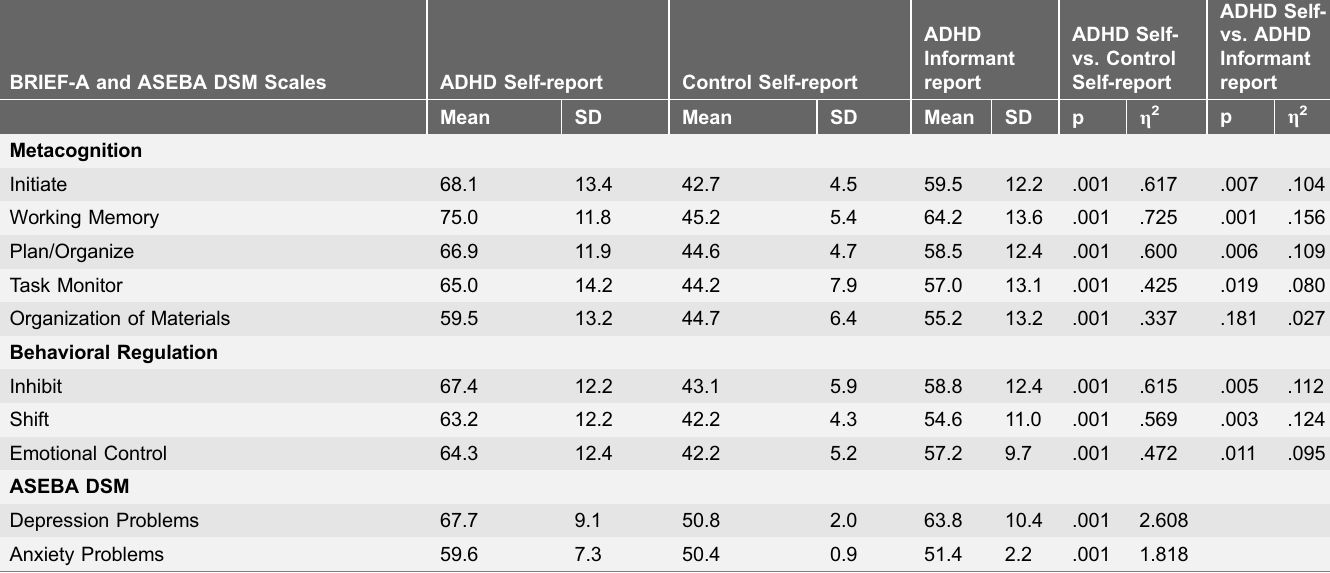
Table 3. BRIEF-A and ASEBA self- and informant report for ADHD patients, and self-report for healthy controls.